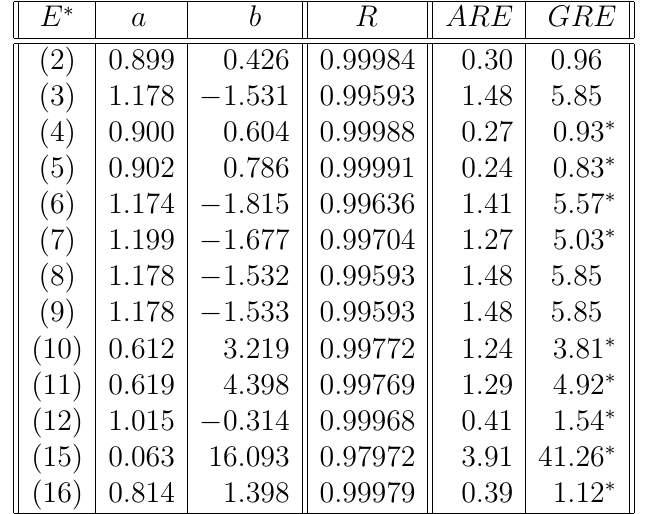
Table 1. Statistical parameters obtained by approximating the total (cid:25) -electron energy as a E (cid:3) + b for the set of 106 benzenoid hydrocarbons from the book [15]. E (cid:3) is the expression on the right{hand side of one of the above given relations; R is the correlation coefficient; ARE and GRE are the average and greatest relative errors (in %); asterisk indicates that the (greatest) error of benzene is